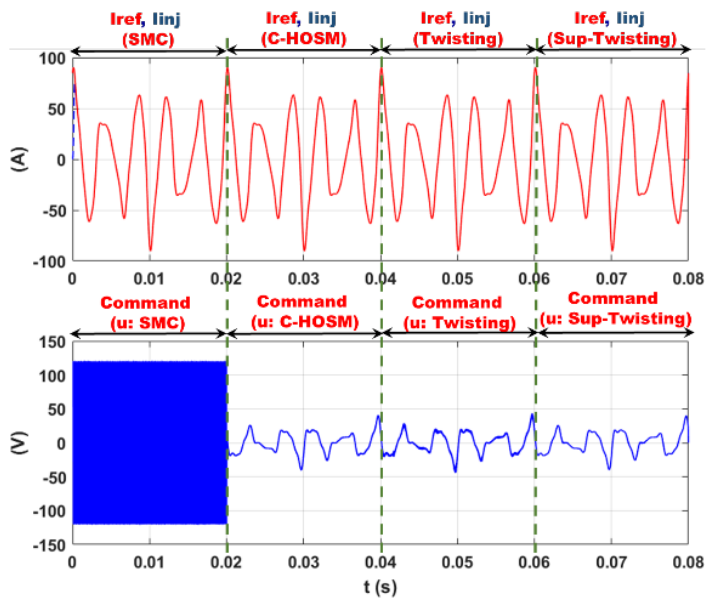
Figure 5. Tracking and controls for the SMC, C-HOSM, 2-SMC Twisting, and Super-Twisting algorithms.